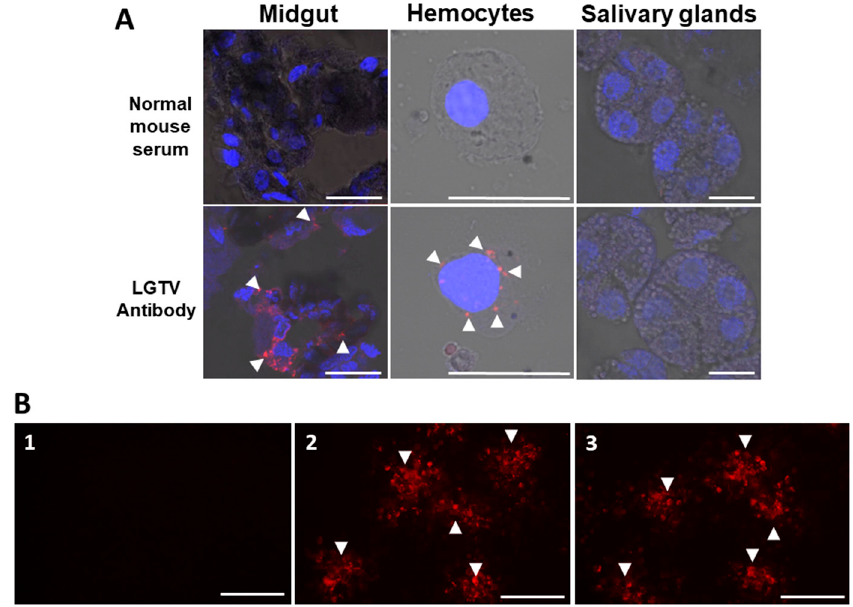
Figure 2. Localization of Langat virusin selected organs from unfed adult ticks after infection via anal pore microinjection and immunofluorescence assay detection of LGTV antibodies in serum samples from mice. ( A ) Viral antigens were detected using a specific LGTV polyclonal antibody, while normal mouse serum served as a control. Nuclei counterstaining (blue) was done using DAPI, and arrowheads denote LGTV antigens (red) (bar = 20 µ m. ( B ) Sera collected from mouse infested with EMEM-injected tick ( 1 ) (1:200, No.1); mouse inoculated with 10,000 ffu of LGTV ( 2 ) (1:12,800, No.1); mouse infested with LGTV-injected tick ( 3 ) (1:6,400, No.18) reacting with LGTV-infected baby hamster kidney cells. Arrowheads denote LGTV ffu detected by LGTV antibodies (red) (bar = 10 µ m).